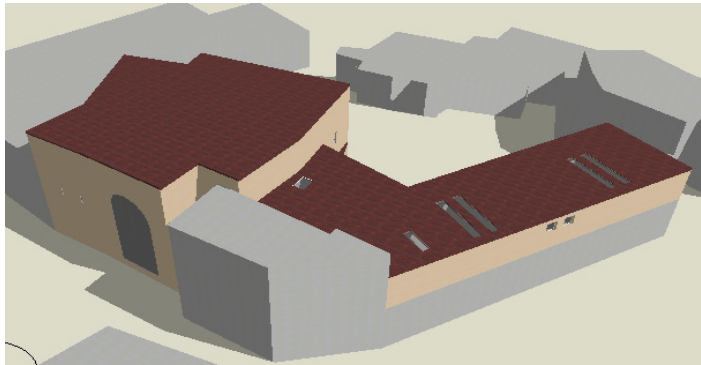
Figure 5. Model of the “Sedile” building.